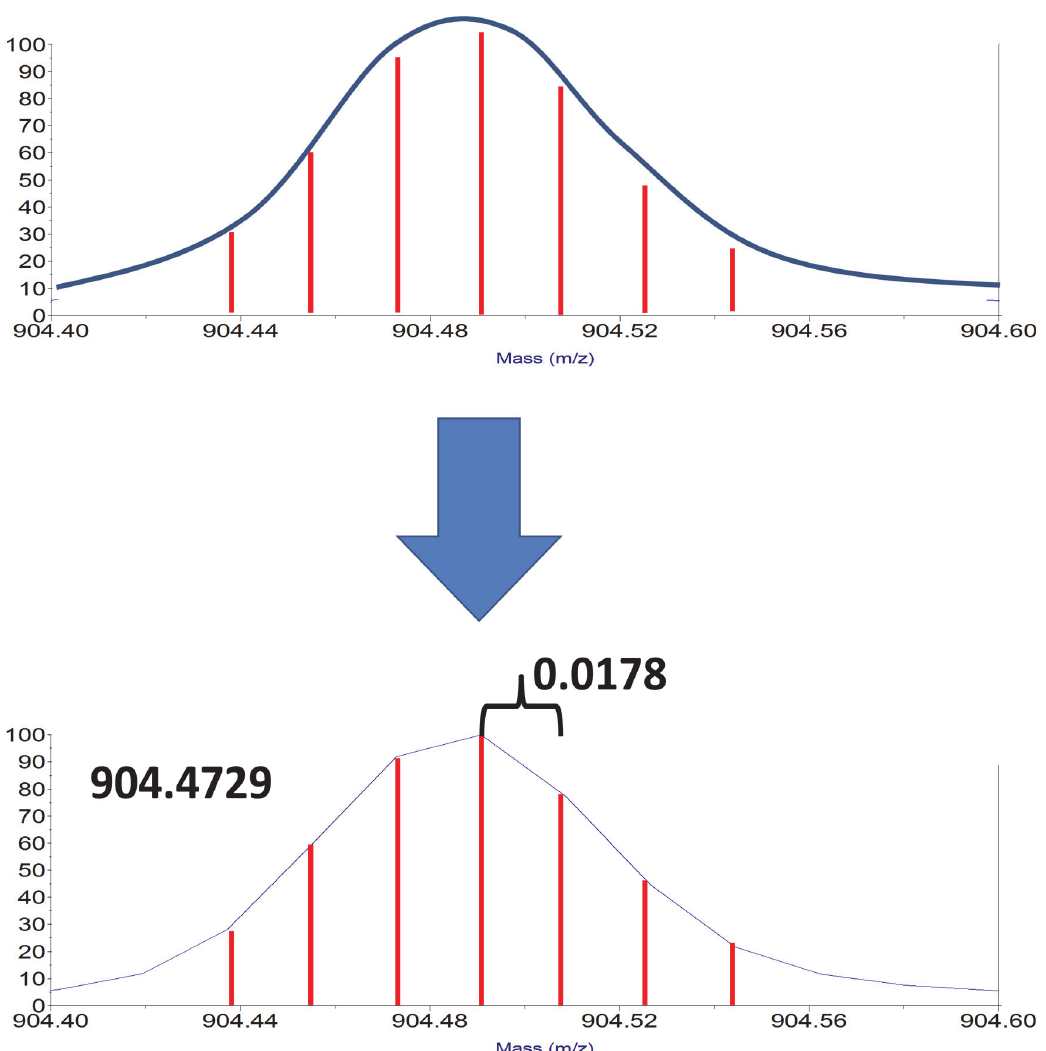
Fig 3. Effect of binning and interpolation in MALDI-TOF data. The signal detected for the flight times of a packet of ions should exhibit a continuum distribution related to the energy distribution of the population of ions (TOP). However, the AD detection system can only measure ion signal from the detector in discrete time intervals represented by the red vertical lines (TOP). The discrete intensity versus time measurements are effectively bins and produce the observed discontinuous peak profile (BOTTOM). This discontinuous data must be interpolated by peak fitting algorithms to estimate the parameters of the original continuum spectrum and derive accurate mass